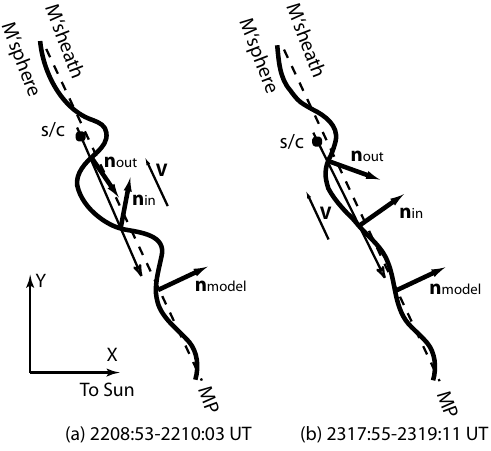
Fig. 6. Surface waves at the magnetopause inferred from the mag- netopause crossings. The dashed line and n model are the local mag- netopause and boundary normal direction predicted by the Petrinec and Russell magnetopause model. The vectors n out and n in are the actual boundary normal directions for the outbound and inbound magnetopause current layer crossings, respectively, obtained from the minimum variance analysis. The solid curve illustrates schemat- ically the surface wave at the